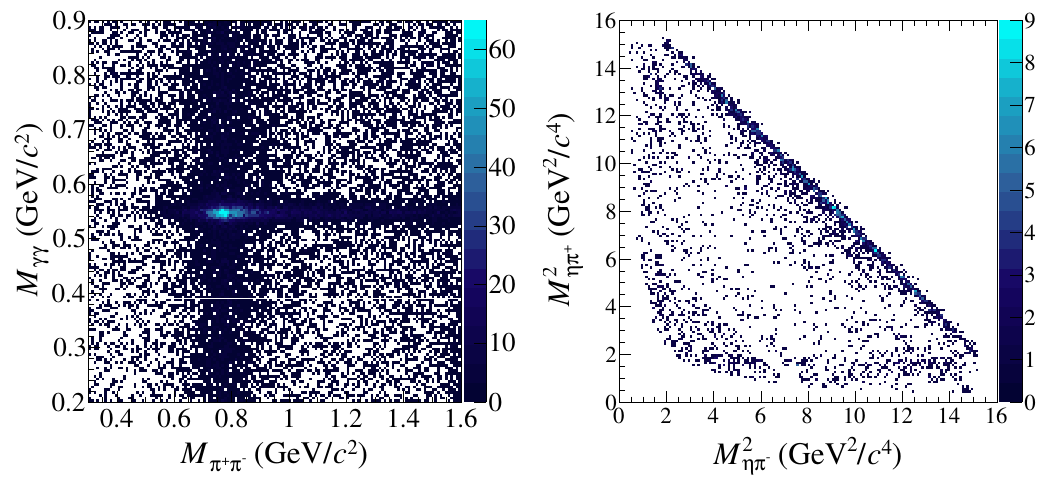
for the candidate events π + π −